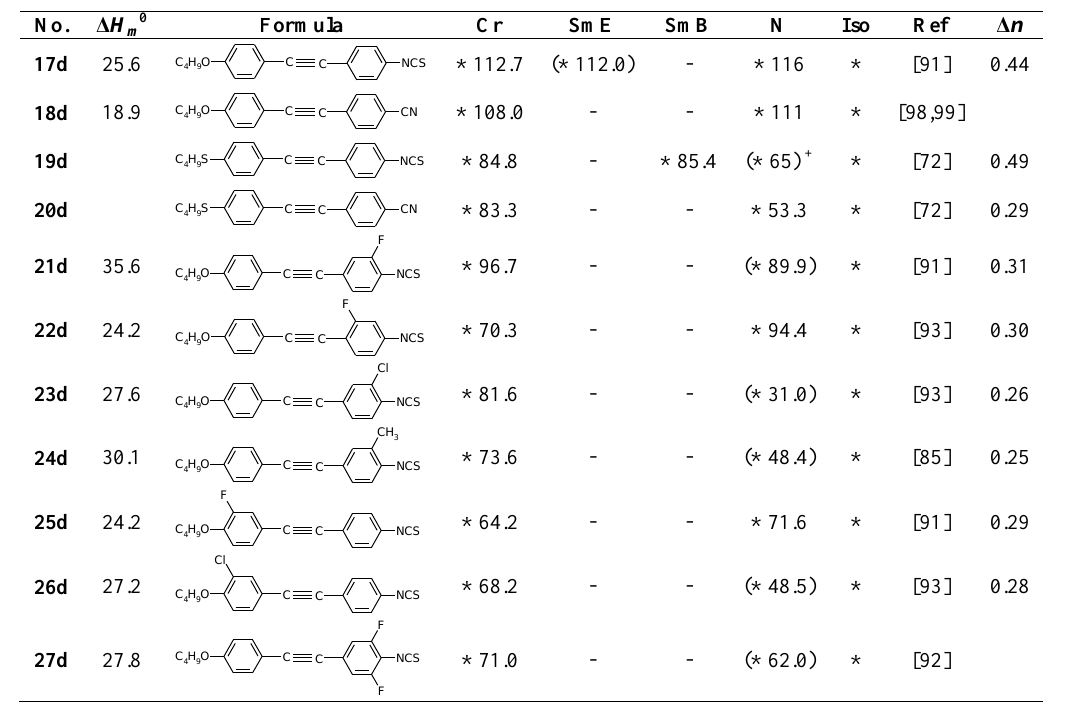
Table 4. Phase transition temperatures [°C], melting enthalpies [kJ/mol] and birefringence of alkoxytolanes and alkylsulphanyl